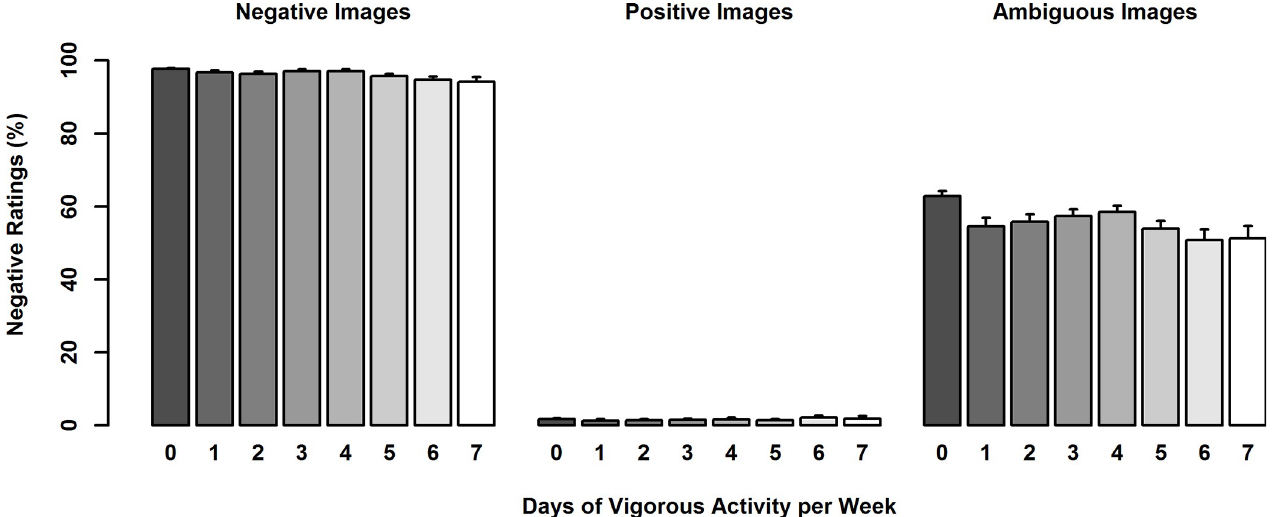
Fig 2. Percent negative ratings of emotional images as a function of vigorous activity in days per week. Ambiguous images were rated more positively by individuals that reported at least one day of vigorous activity per week as compared to those who reported no vigorous activity per week (p = .002; surviving a Bonferroni corrected significance p < .007). All other adjacency comparisons were not significant (p’s > .13).